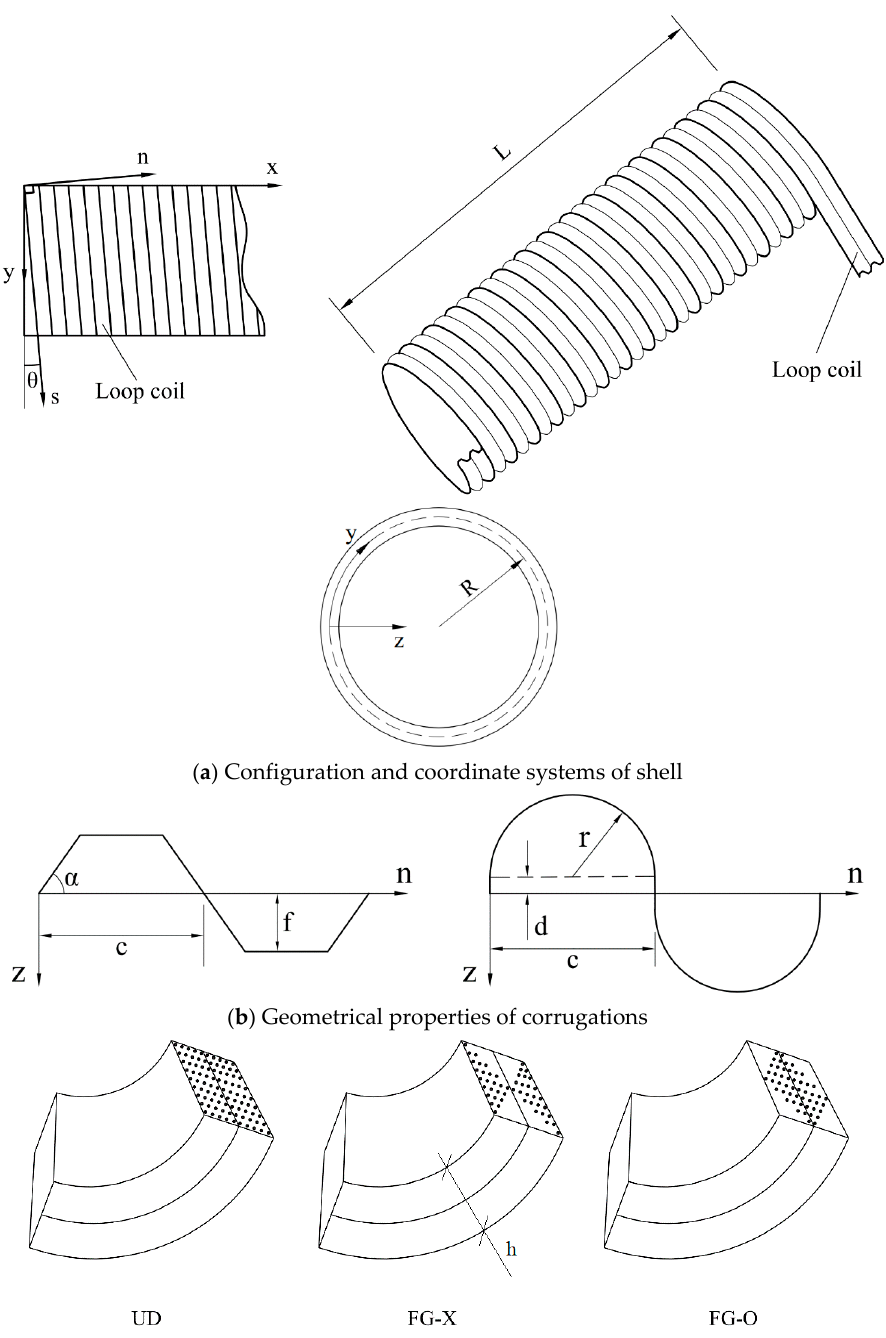
Figure 1. Geometrical properties and coordinate system of spiral corrugated functionally graded carbon nanotube reinforced composite (FG-CNTRC) cylindrical shells.